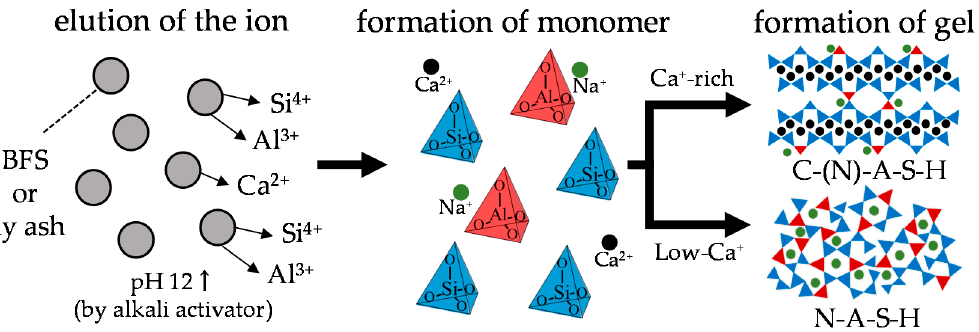
Figure 1. Reaction mechanisms of alkali-activated slag and fly ash.